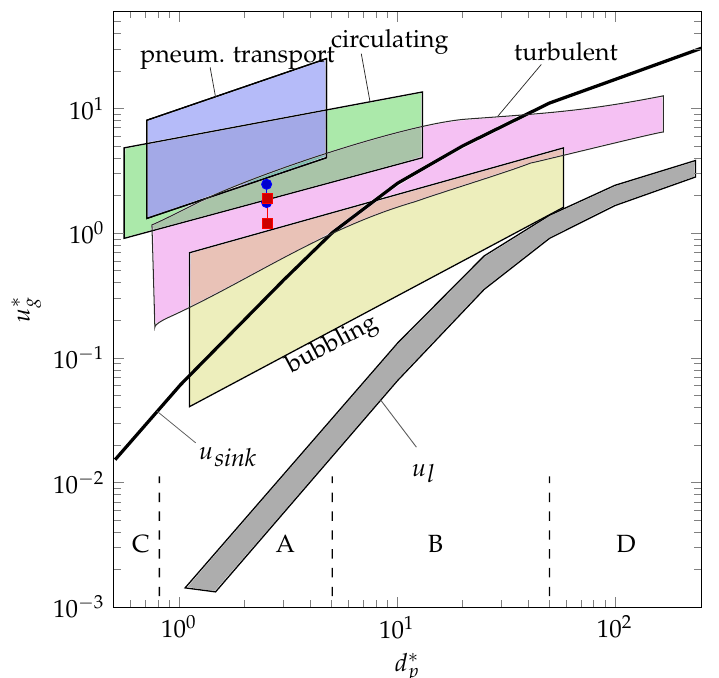
Figure 3. Grace diagram indicating the operation regimes of the FR and AR